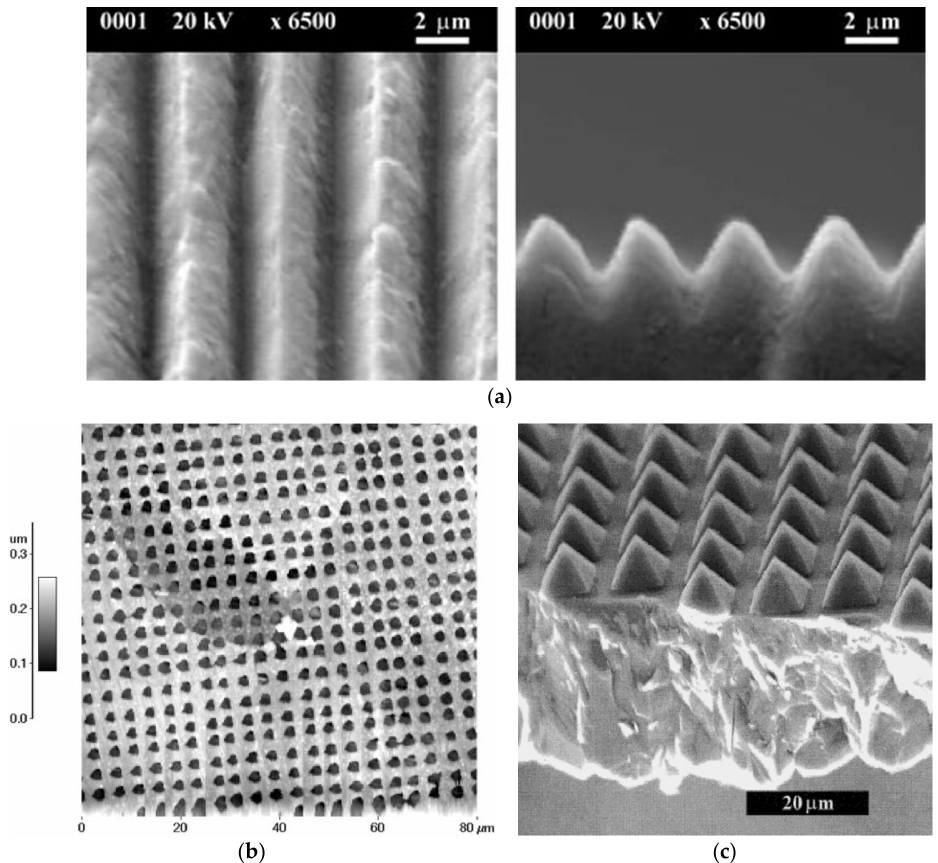
Figure 2. Scanning electron micrographs of periodic structures developed by UV excimer laser.